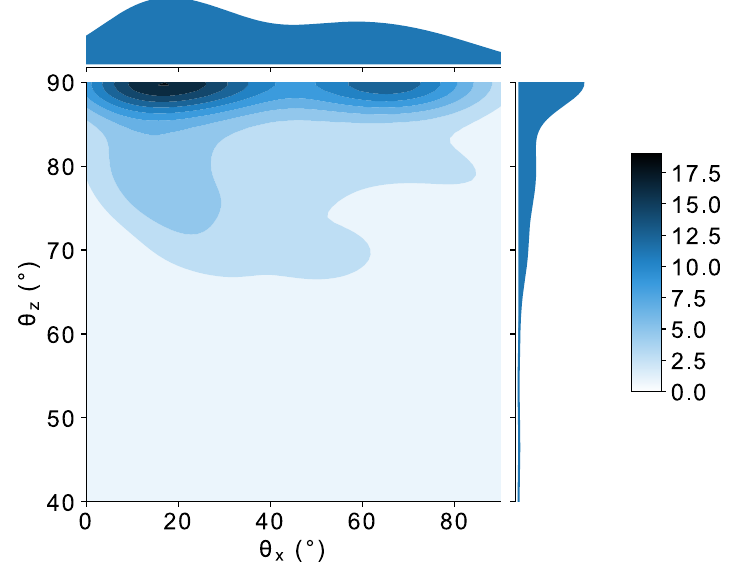
Figure 9. Density map for 3D principal Feret orientations with respect to the x and z directions. Density function shape for θ x and θ z are respectively plotted parallel to the corresponding axis. The z direction is a radial direction of the ingot, and the x direction is opposite